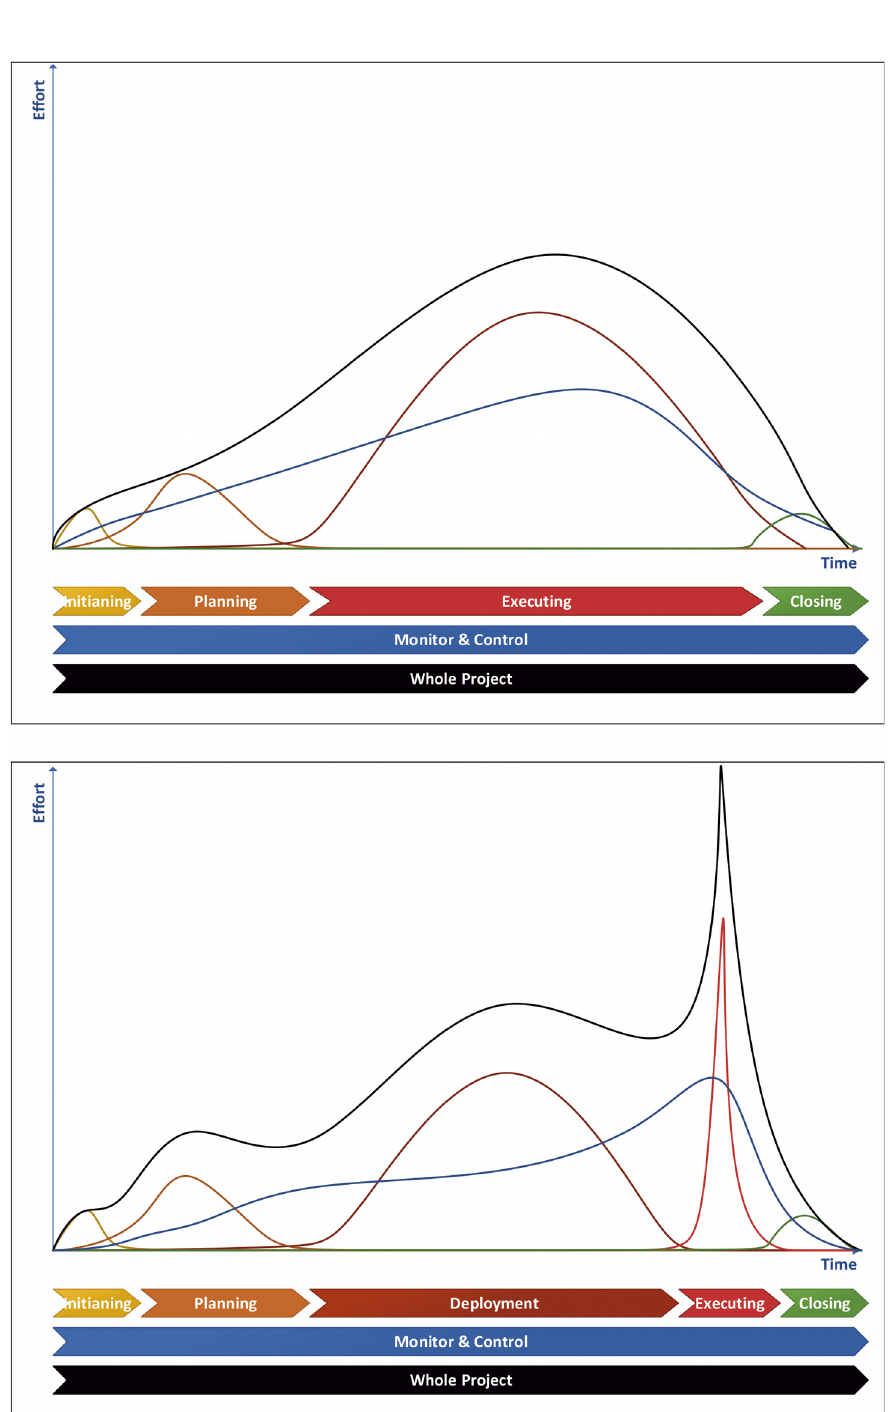
Figure 1. Comparison of the original PM 2 lifecycle and the sports events